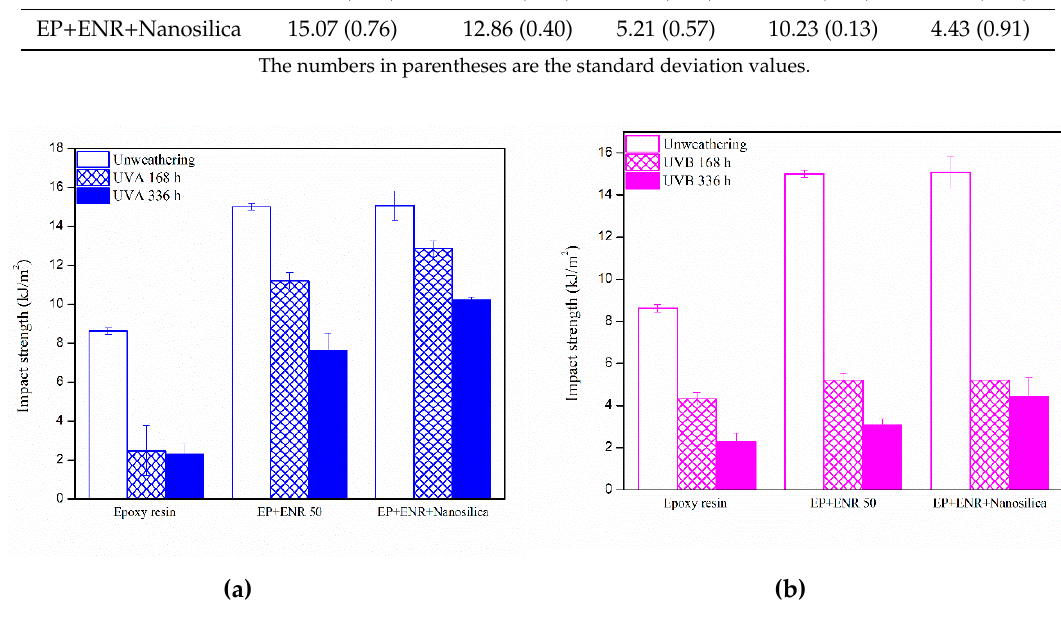
Figure 4. Thermogravimetric analysis (TGA) Thermogram of nanocomposites.